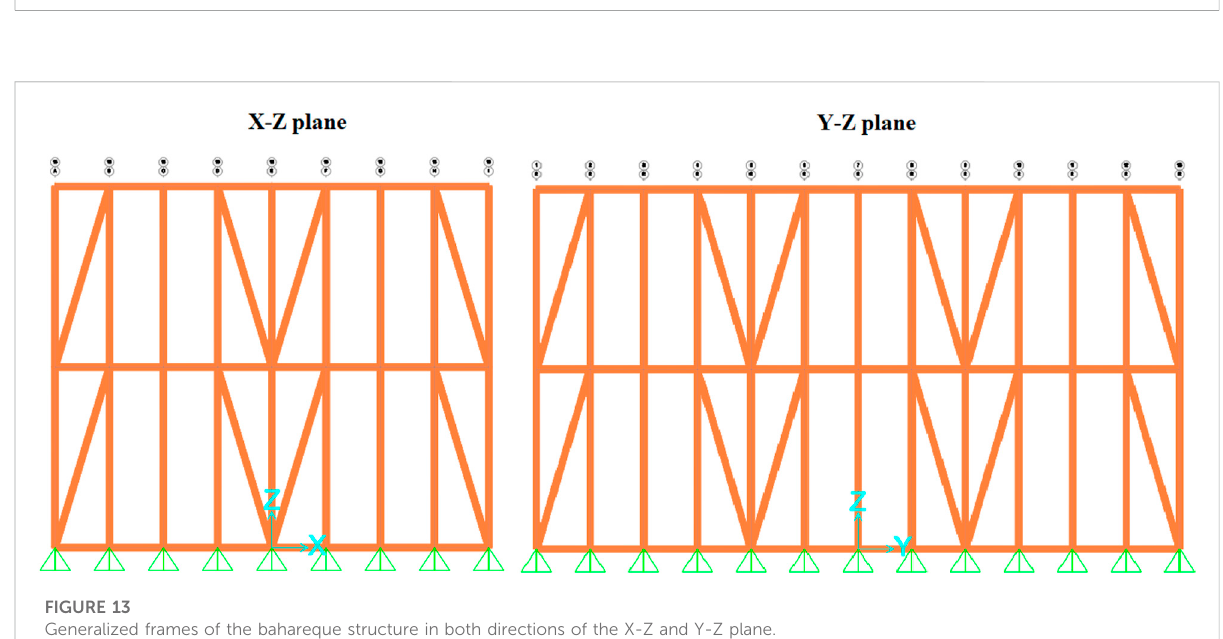
Frontiers in Built